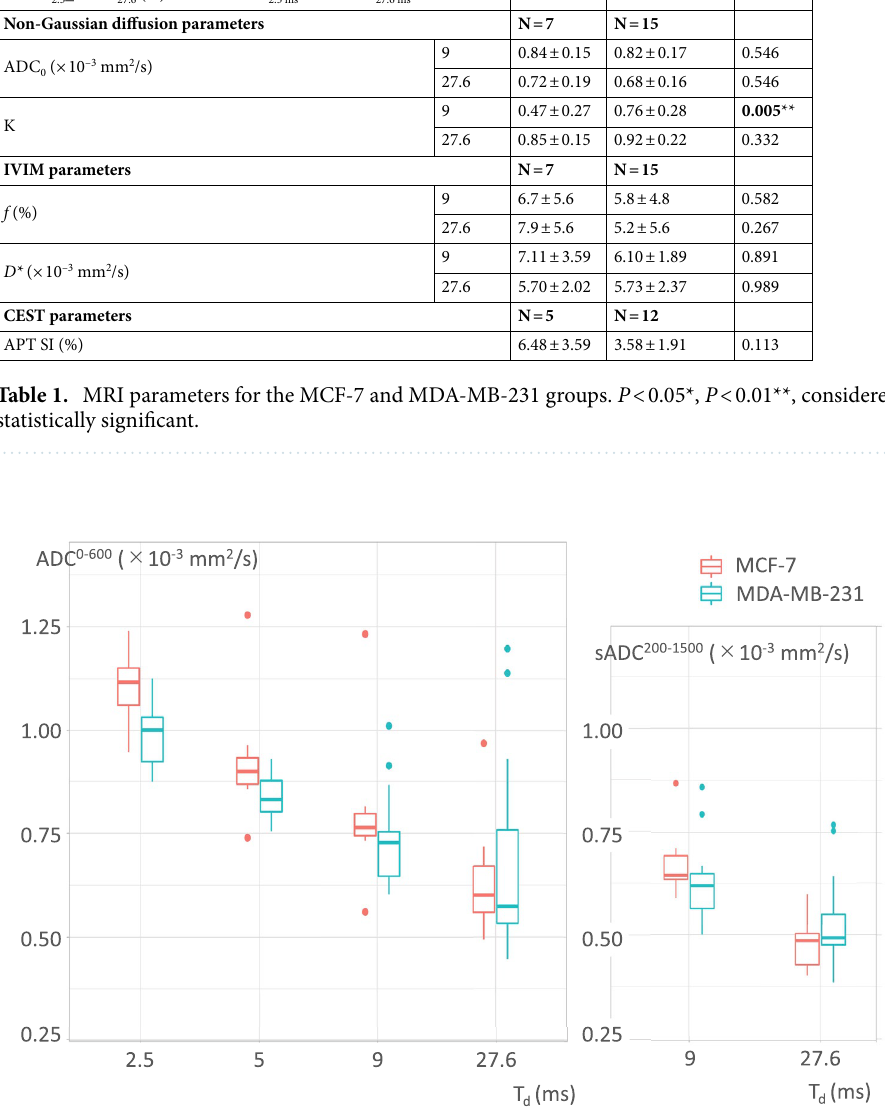
Figure 1. Box-whisker plots of ADC 0–600 and shifted ADC 200–1500 (sADC 200–1500 ) against diffusion